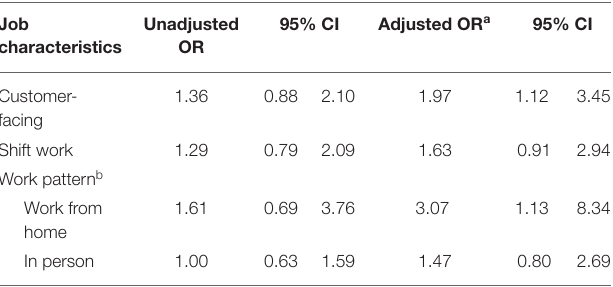
TABLE 4 | Associations between customer facing, shift work, work pattern, and risk of testing positive for SARS-CoV-2 by RT-PCR assays among the study